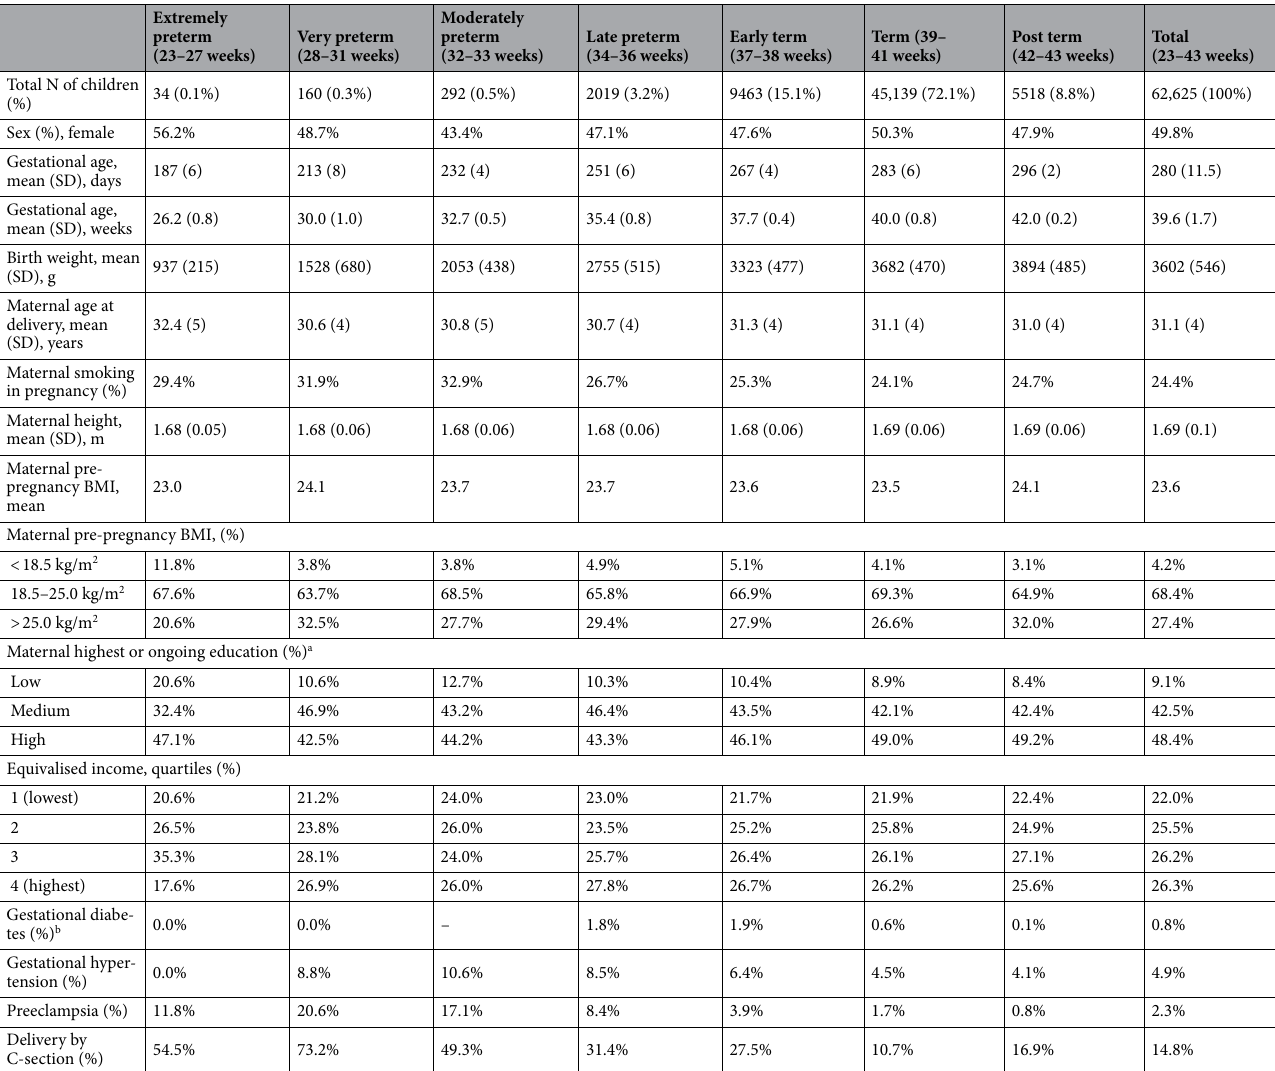
Table 1. Selected characteristics of the study population from children born in the Danish National Birth Cohort (1996–2003), n = 62,625. SD standard deviation, BMI body mass index, C-section caesarean section. a ISCED 11 is used for classification of maternal educational level. b For moderately preterm, information on gestational diabetes was omitted due to disclosure control and low numbers (< 5) in